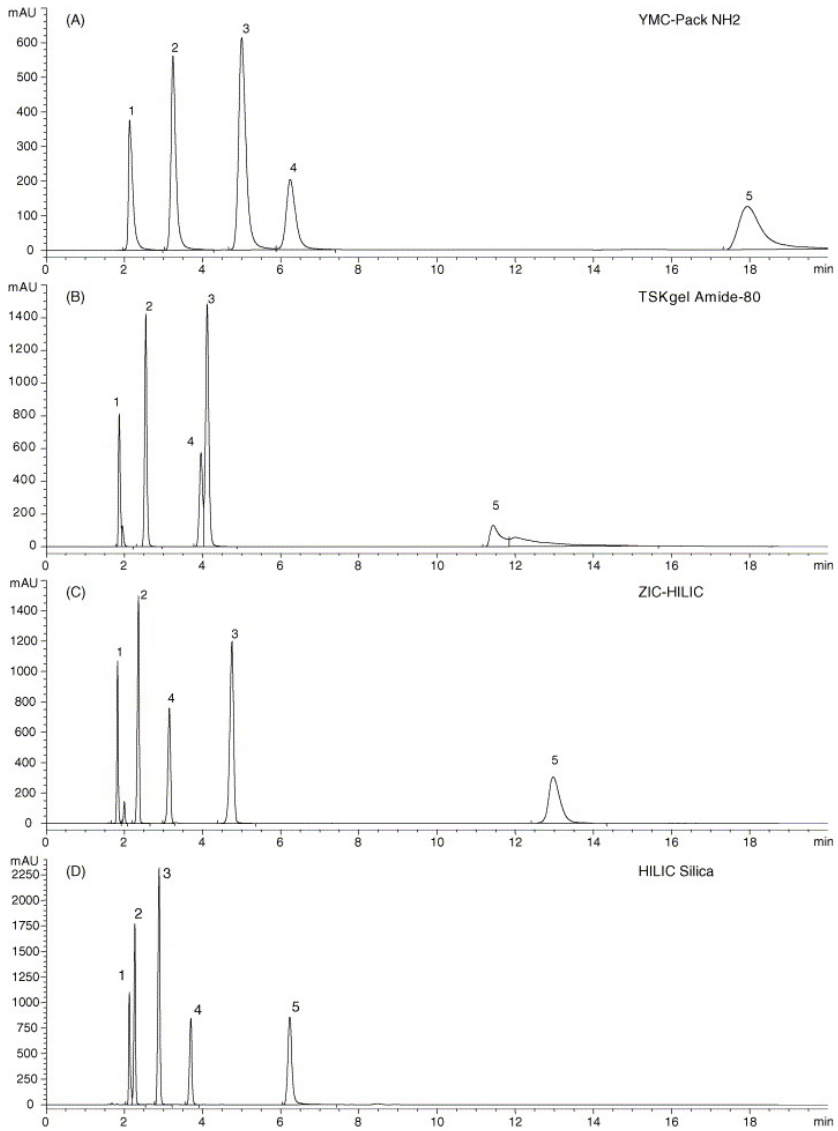
Figure 1. Separation of acidic compounds (1: salicylamide, 2: salicylic acid, 3: 4-aminosalicylic acid, 4: acetylsalicylic acid, and 5: 3,4-dihydroxyphenylacetic acid) on ( A ) YMC-Pack NH2; ( B ) TSKgel Amide-80; ( C ) ZIC-HILIC; and ( D ) HILIC silica columns. Reproduced with permission [8].